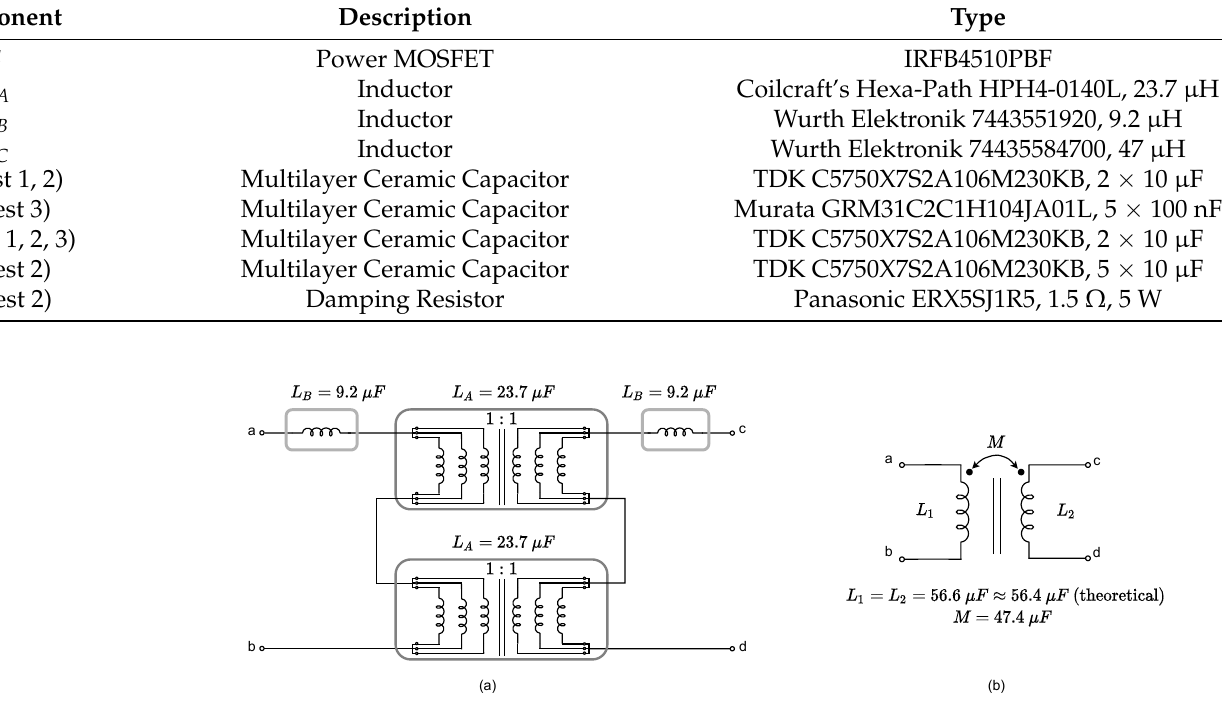
Figure 13. Arrangement to obtain the inductors with magnetic coupling: ( a ) interconnections between inductors, ( b ) equivalent coupled inductors.